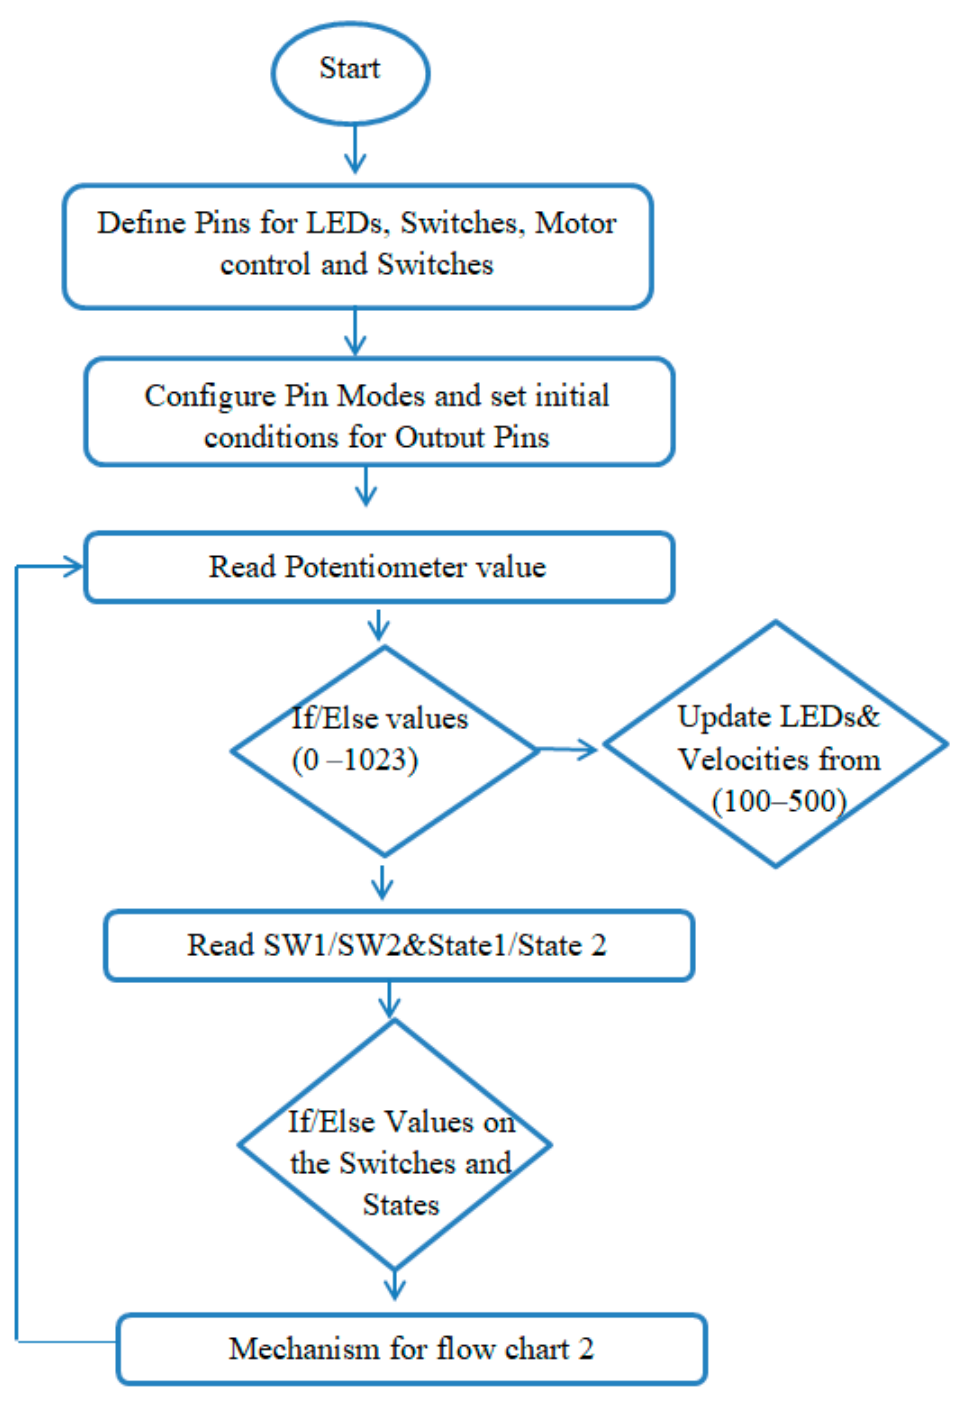
Figure 3. Flow chart of the Arduinio program to control the movements of machines through stepper motor.